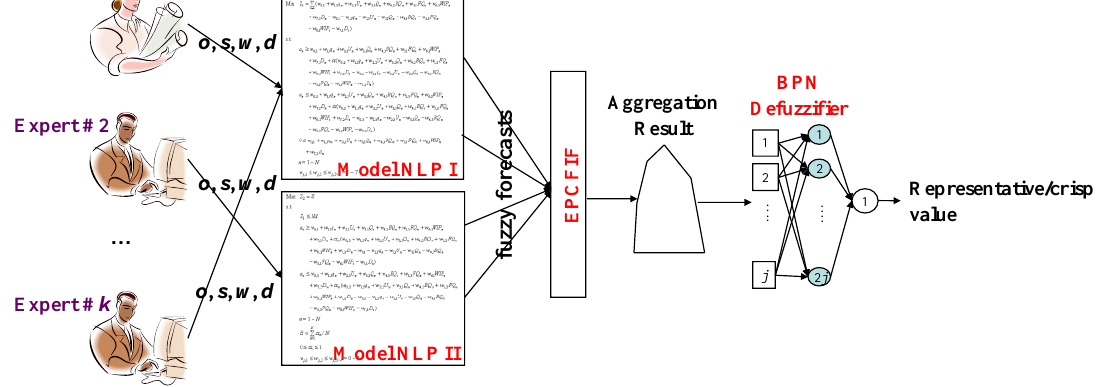
Figure 1. Proposed methodology procedure